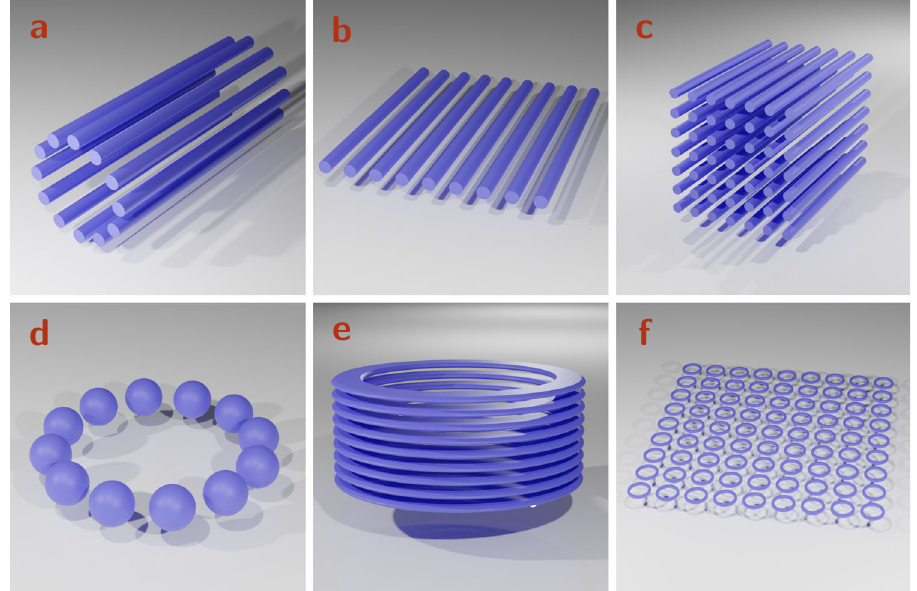
Fig. 1 Schematic showing typical multimoded optical settings where out theory can be applied to derive a thermodynamic pressure. A one-dimensional array consisting of evanescently coupled single-mode waveguides in a a circular (normal polygon with the waveguide at the vertices) and b a linear geometric con fi guration. c A two-dimensional waveguide array forming a rectangular lattice. A one-dimensional coupled resonator array in d a circular and e a vertical ring arrangement. f A two-dimensional rectangular lattice of ring resonators. In the fi rst column, the boundary conditions are periodic, whereas in the second and the third columns, the boundary conditions are